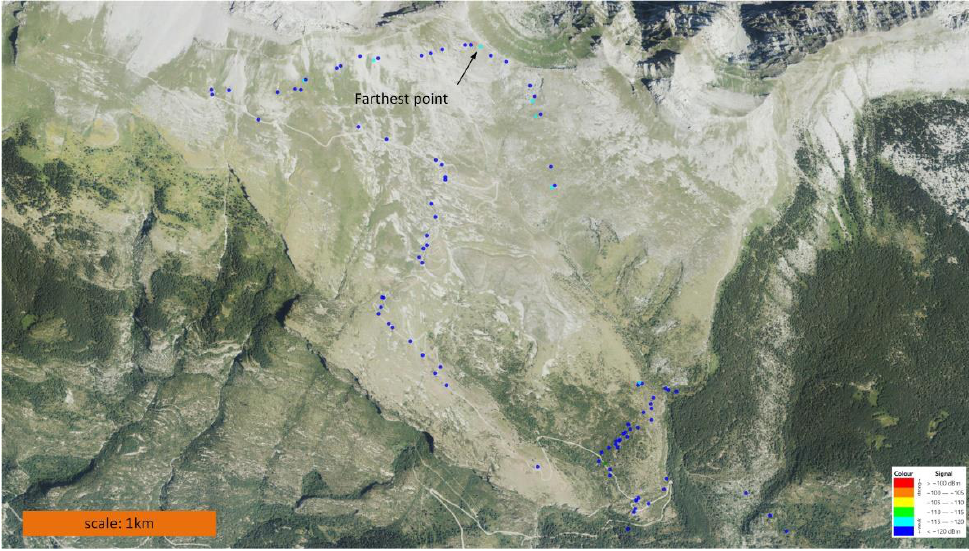
Figure 10. Data reports received. Distance from gateway to farthest point is 12 km.